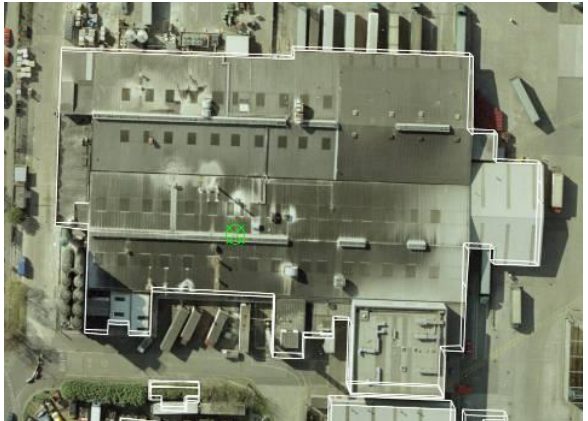
Figure 3. A complex building with more than 50 sides, extracted from a LIDAR point cloud: stereo images are used only to verify the accuracy of the extracted building.